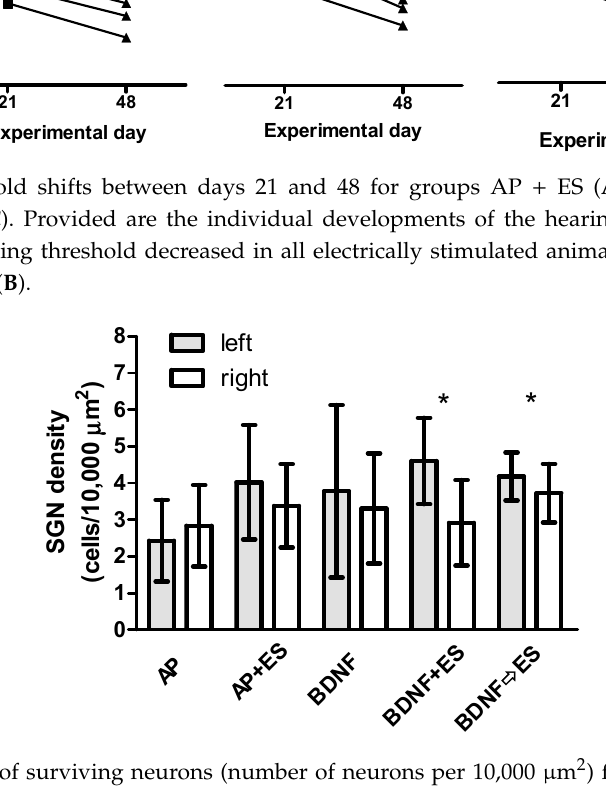
Figure 6. Median as well as minimal and maximal values of the density of protected SGN (density of neurons on the treated side minus density on the untreated side). Only in the BDNF + ES group, the